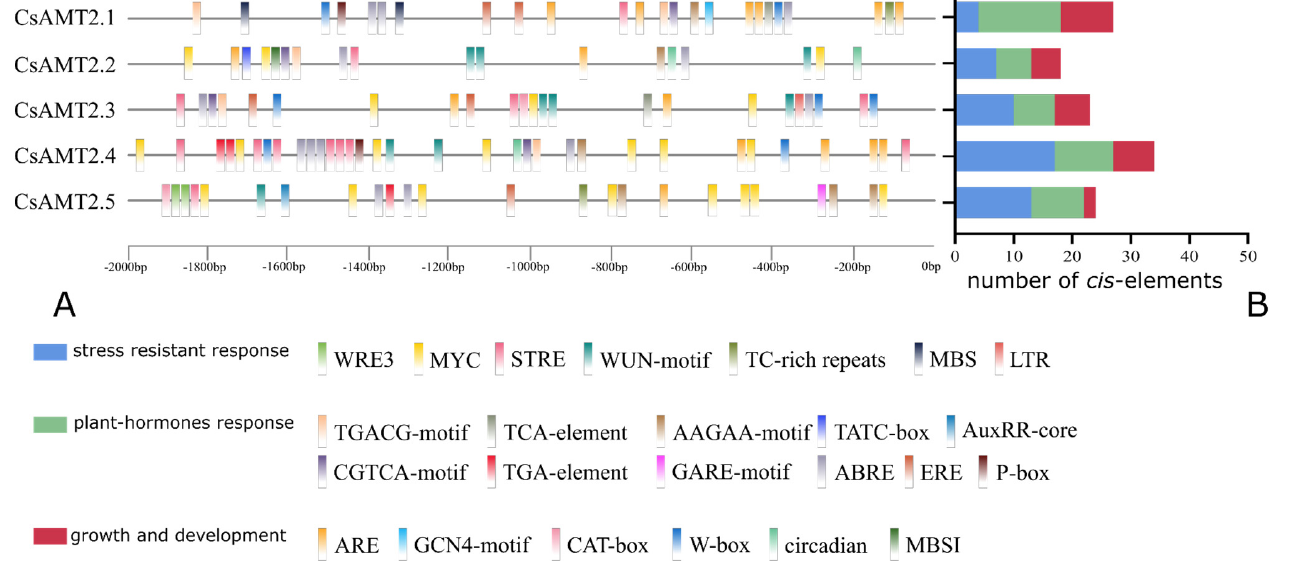
Figure 2. Predicted cis -elements in CsAMT2 promoters. ( A ) Analysis of cis-elements in the upstream 2000 kb region of CsAMT2 family genes in tea plants; different types of cis-elements are indicated by different colored blocks. ( B ) The three types of cis -elements are related to growth and development, stress resistant responsiveness, and plant hormones responsiveness.